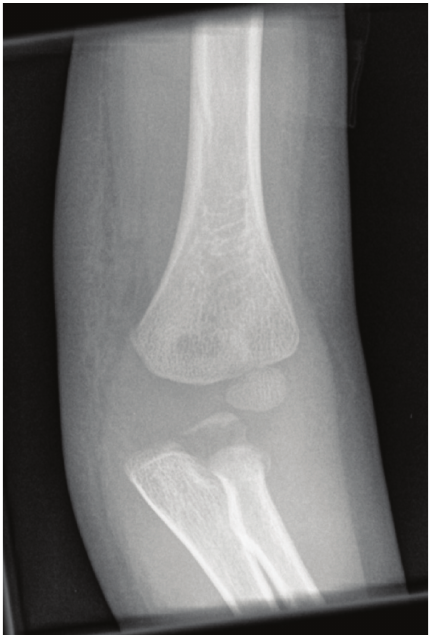
Figure 4: Anterioposterior radiograph of the same elbow twelve days after injury. Bony fragment still